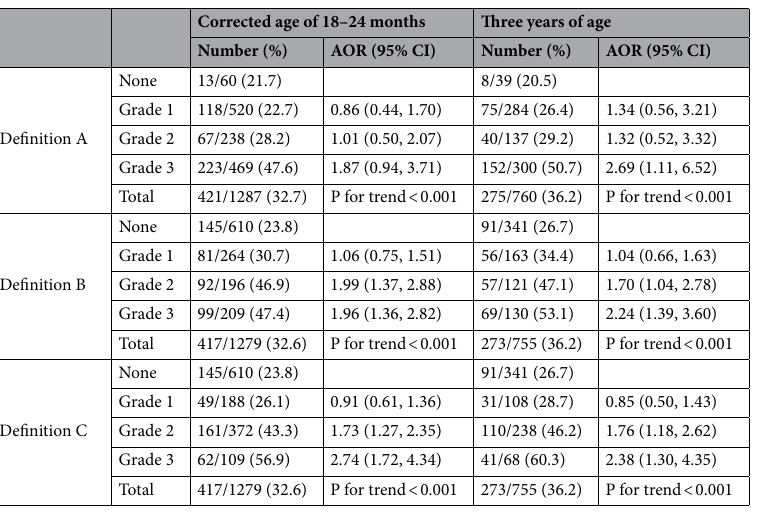
Table 3. Neurodevelopmental impairments at a corrected age of 18–24 months and at 3 years of age according to the severity of bronchopulmonary dysplasia per each definition. AOR adjusted odds ratio; CI confidence interval. ORs were adjusted for gestational age, small for gestational age, intraventricular hemorrhage (≥ grade 3), periventricular leukomalacia, necrotizing enterocolitis (≥ stage 2), retinopathy of prematurity (requiring surgery), and sepsis using multivariable logistic regression. Neurodevelopmental impairment was defined as mental developmental delay, motor developmental delay, or social developmental